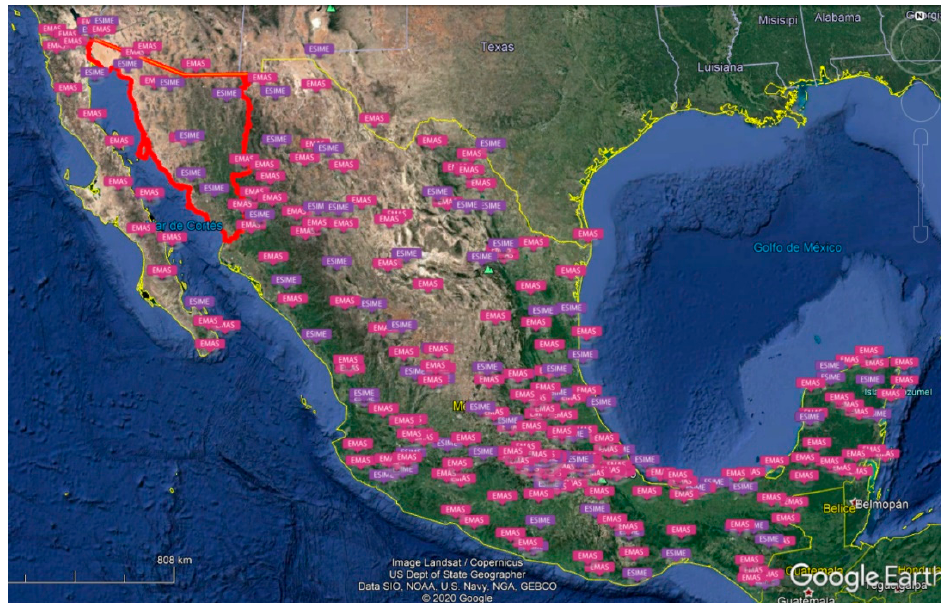
Figure 1. Location of meteorological stations from the SMN in Mexico, highlighting the state of Sonora with a red outline [7,10].